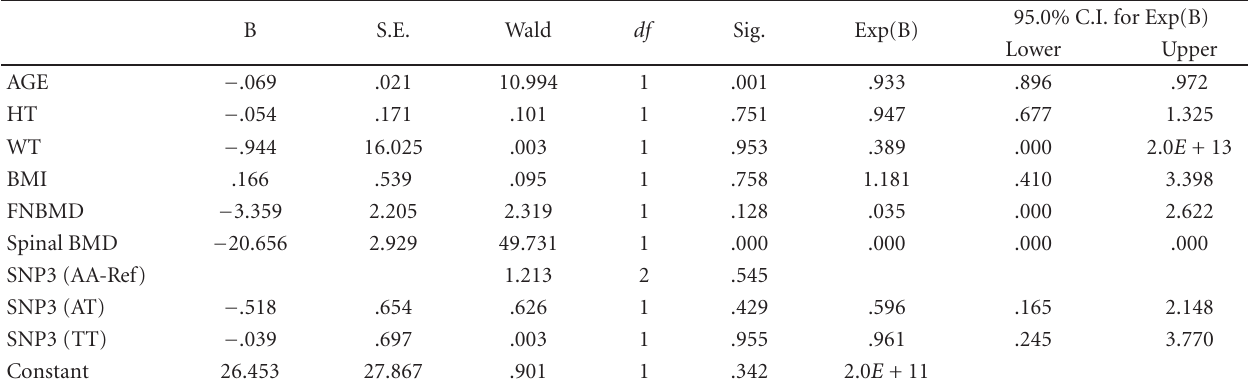
Table 5: Logistic analysis of BMP2 SNP2